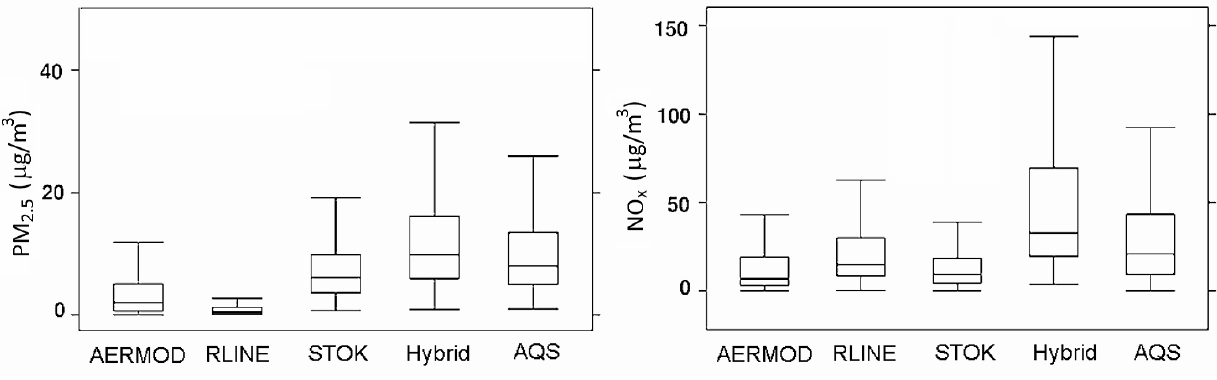
and NO concentrations for 2010 at 2.5 x averaged, and one NO 2.5 x